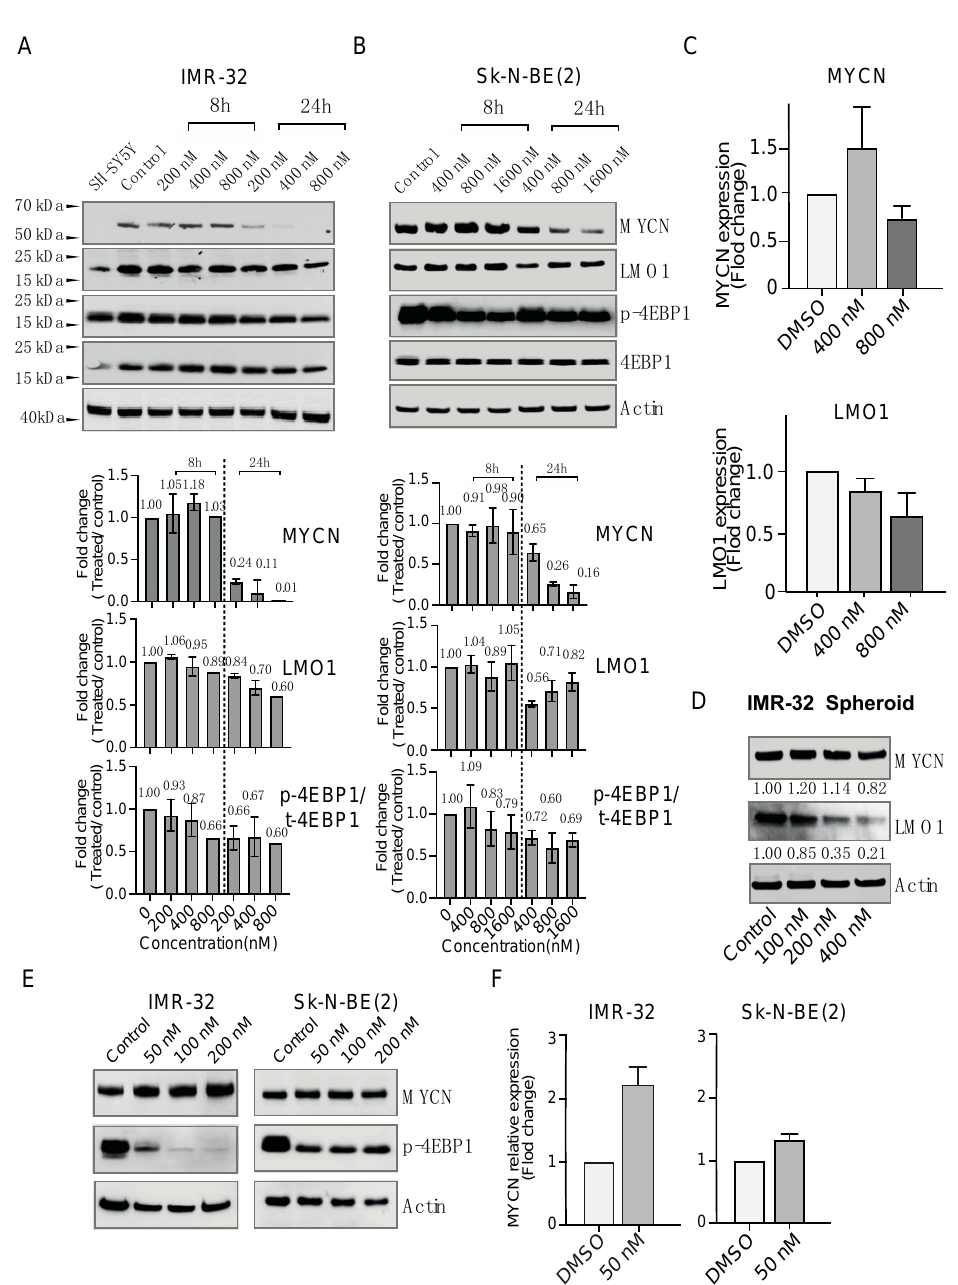
analysis. We did notice a strong and moderate level of reductions for LMO1 and MYCN, respectively (Figure 4D), However, a sole inhibition on the mTOR/PI3K pathway with an inhibitor BEZ-235 was not able to significantly reduce the expression of MYCN both at the translation level and transcript level (Figure 4E,F, respectively), suggesting that mitochondrial inhibition is a major cause of MYCN reduction and mTOR is not upstream of MYCN regulation.